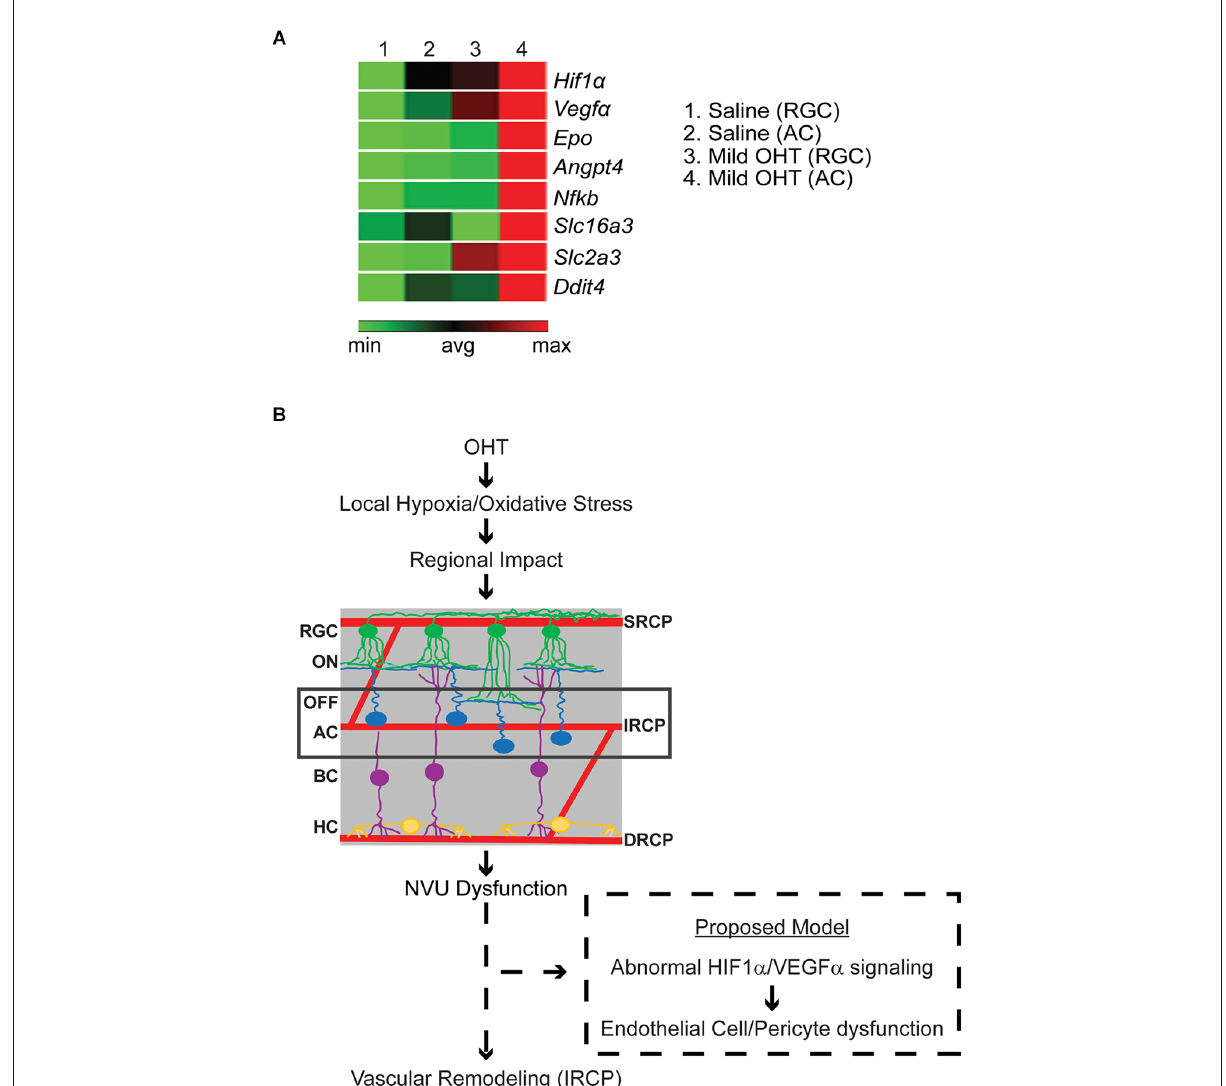
FIGURE6 (A) Relative gene expression of hypoxia pathway genes in pooled immunopanned amacrine cells (ACs) and retinal ganglion cells (RGCs) from mild OHT and saline control eyes. RT Profiler was used to quantify the relative expression of multiple hypoxia genes. After IOP elevation, ACs (column 4), but not RGCs (column 3), show a relative increase in expression (red) of the HIF1 α -target genes VEGF α , Epo, Angpt4, Nfkb, Slc16a3, Slc2a3, and Ddit4 ( n = 3 biological replicates). (B) Potential model of OHT impact on the retinal vasculature. With mild OHT, the resulting